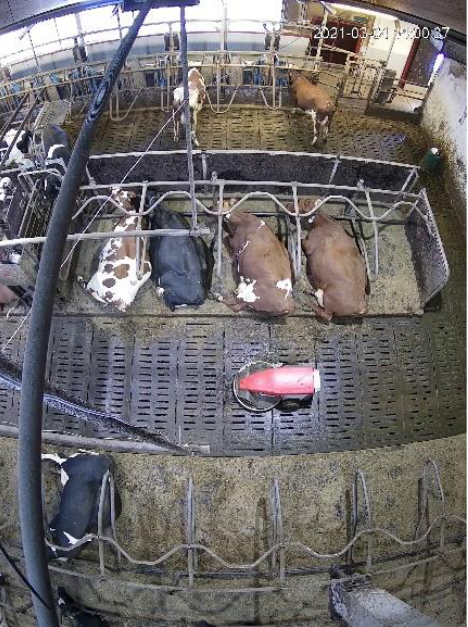
Figure 1. Top-view image of the research barn acquired by one of the cameras.